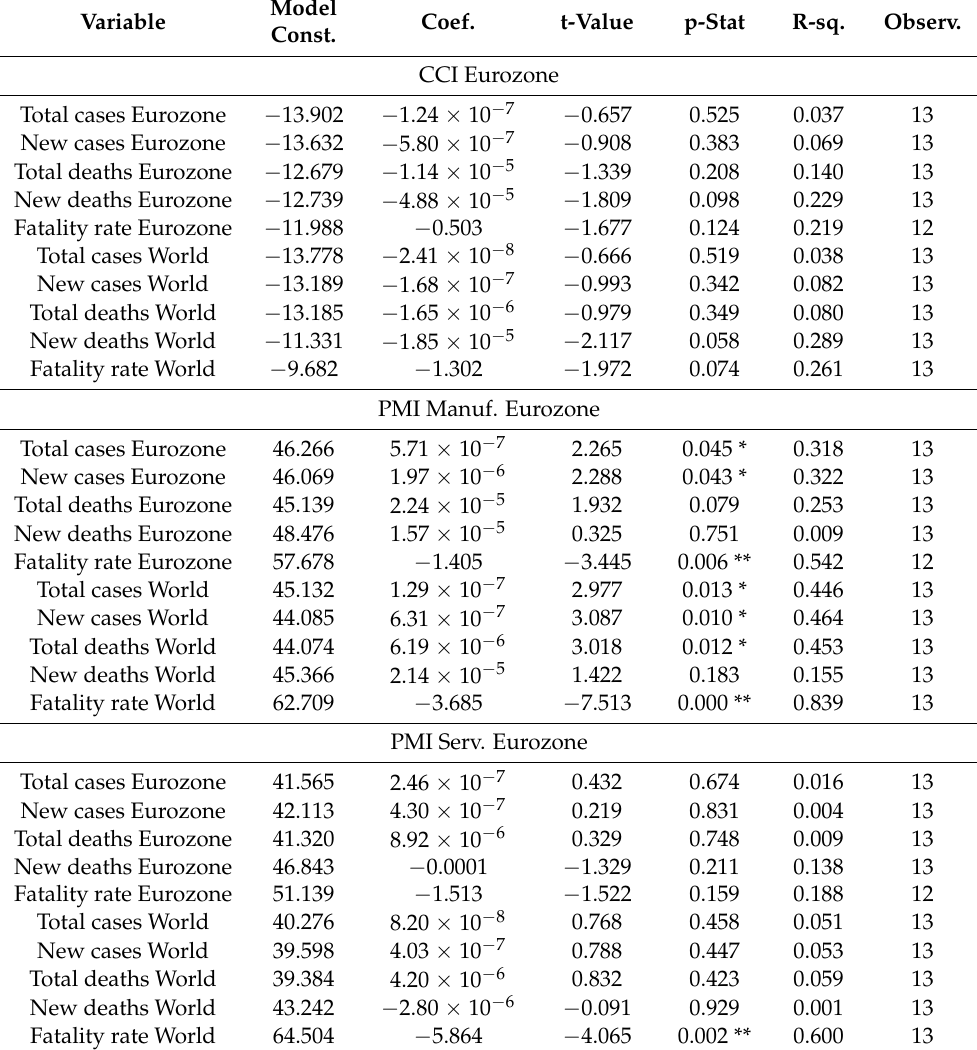
Table 4. Regression models for COVID-19’s effect on the Eurozone economic-sentiment